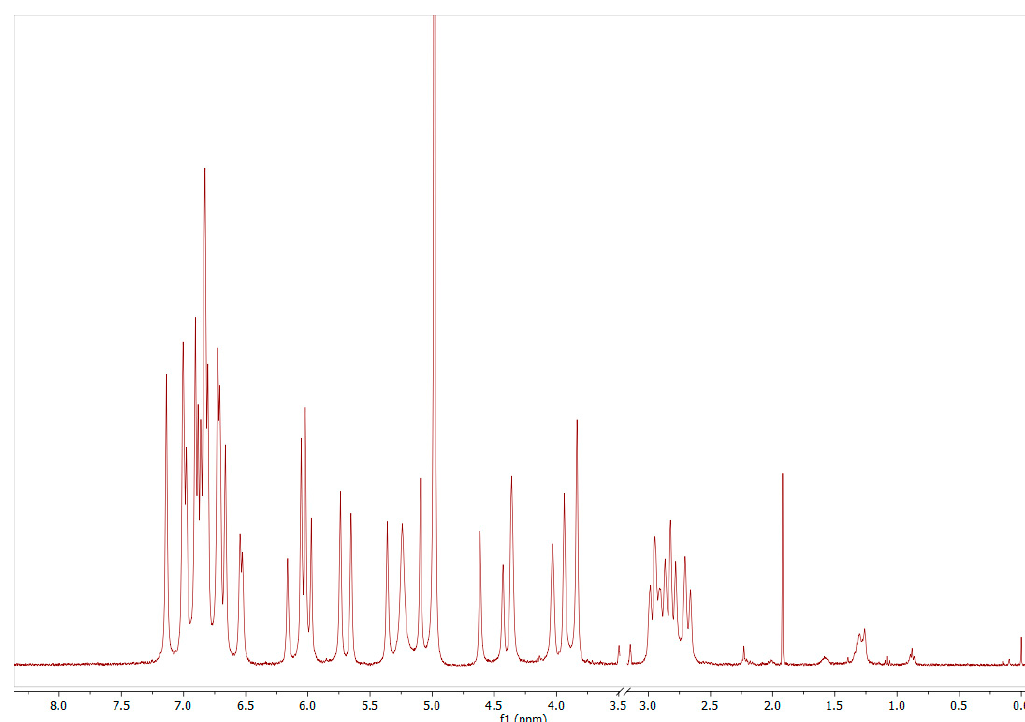
Figure 5. 1 H-NMR example spectrum of procyanidin-B2 (1868 mg/L) in methanol-d 4 /D 2 O (50/50, v/v ). The signals in the range of 6.5–7.15 ppm (the six protons of Ring B and E) and 2.6–3.0 ppm (the two diastereomeric protons F4) were used for summary quantification (Figure 1, 1 H-NMR spectra with signal assignments for all PP are provided in the Supplemental Material Figure S4, including references).